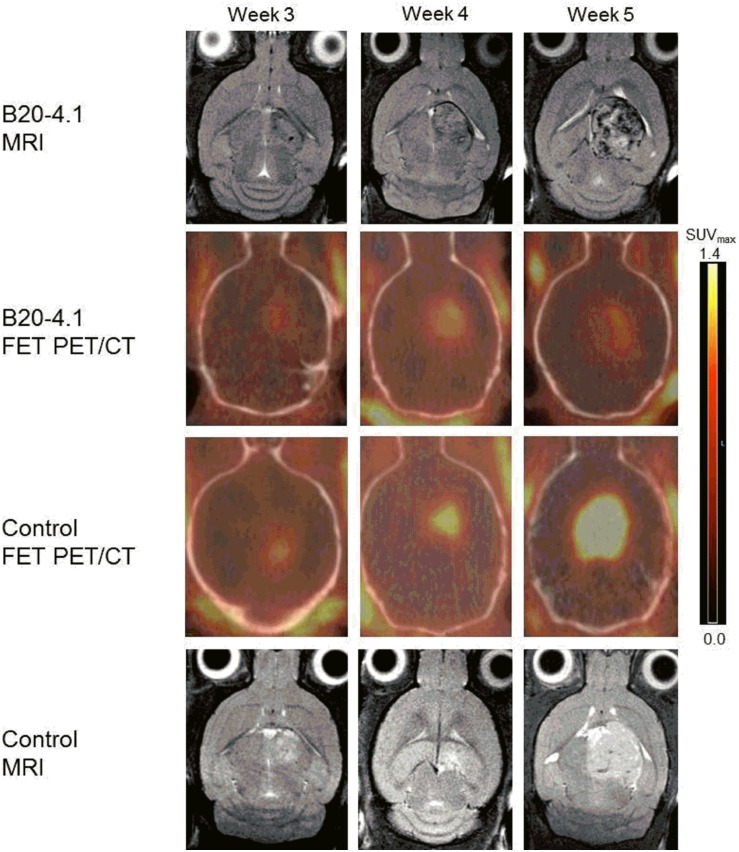
Illustration of tumour progression and treatment response.T2w-MRI and fused 18F-FET MicroPET/CT images showing tumour progression 3–5 weeks after tumour cell injection. Transverse views through the brain of a mouse from the B20–4.1 group and a mouse from the control group. Scale bar: 0–1.4 SUVmax